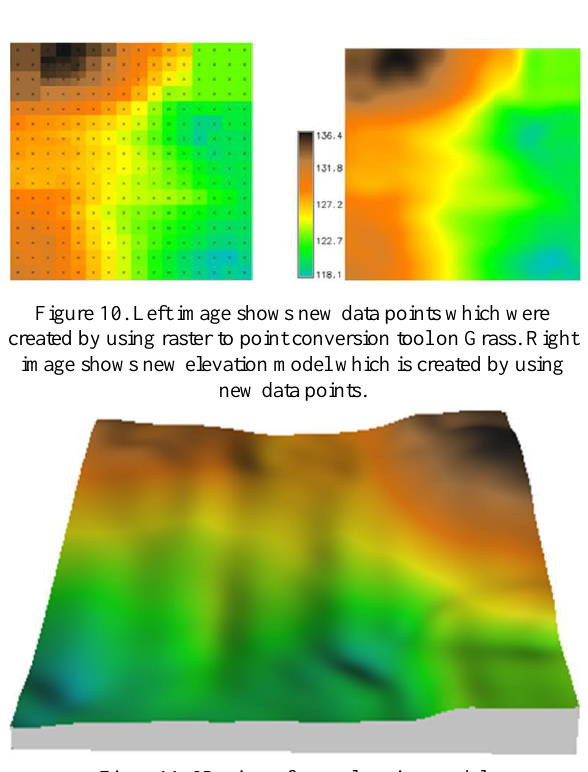
Figure11. 3D view of new elevation model